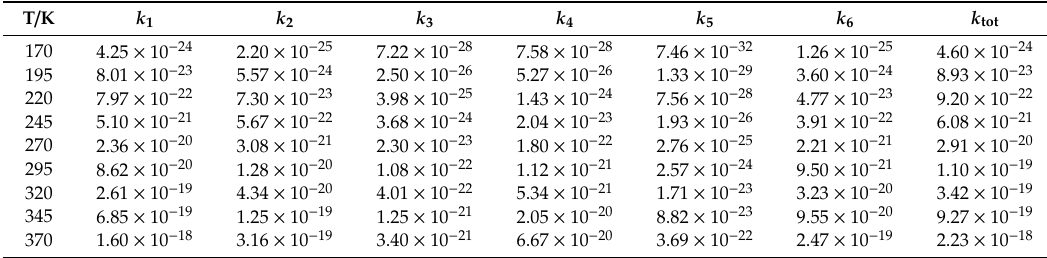
Table 1. The overall and individual rate constants ( k i / cm − 3 molecule − 1 s − 1 ) at 1 atm and over the temperature range of 170–370